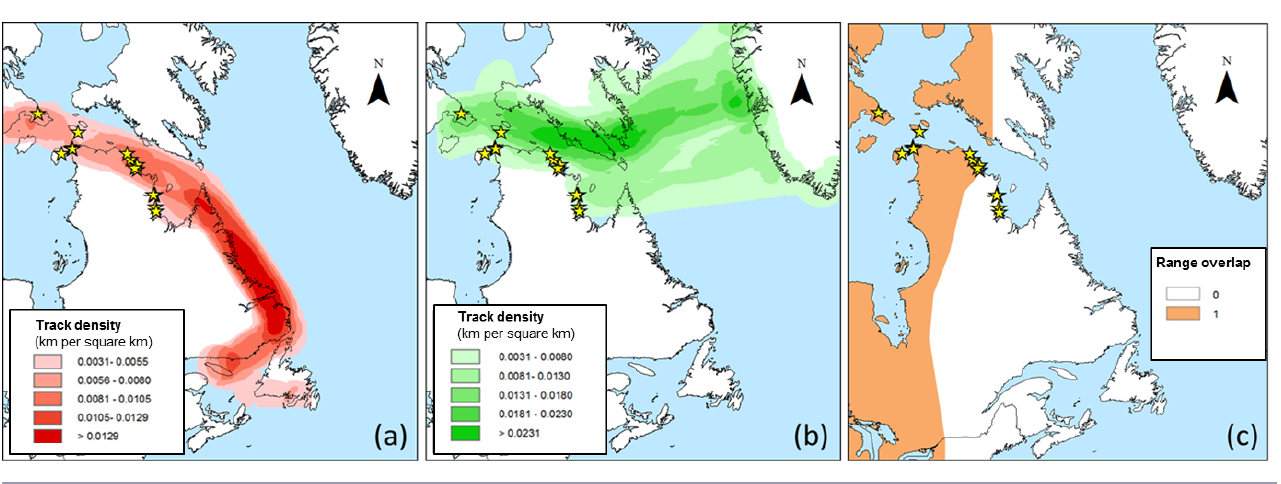
Fig. 3 . Avian Cholera outbreak locations in relation to the migratory flyways of (a) Common Eiders ( Somateria mollissima ) wintering in Atlantic Canada, (b) Common Eiders wintering in Greenland, and (c) Lesser Snow Geese ( Chen caerulescens caerulescens ) wintering in the central United States. Stars indicate locations where outbreaks have been reported.